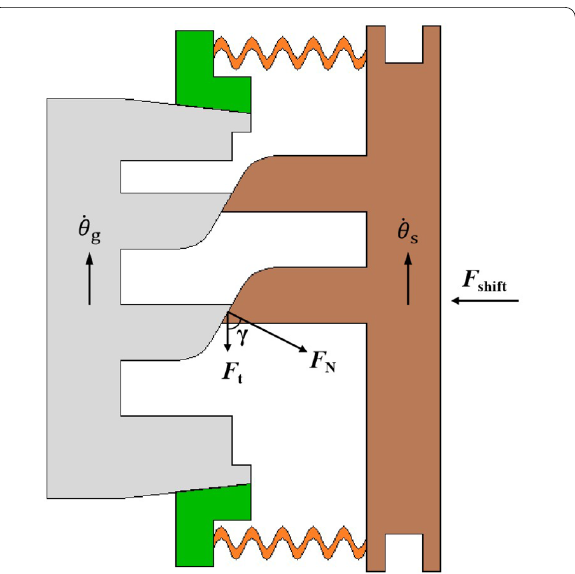
Figure 15 Schematic diagram of the structure of the sleeve and the friction cone ring